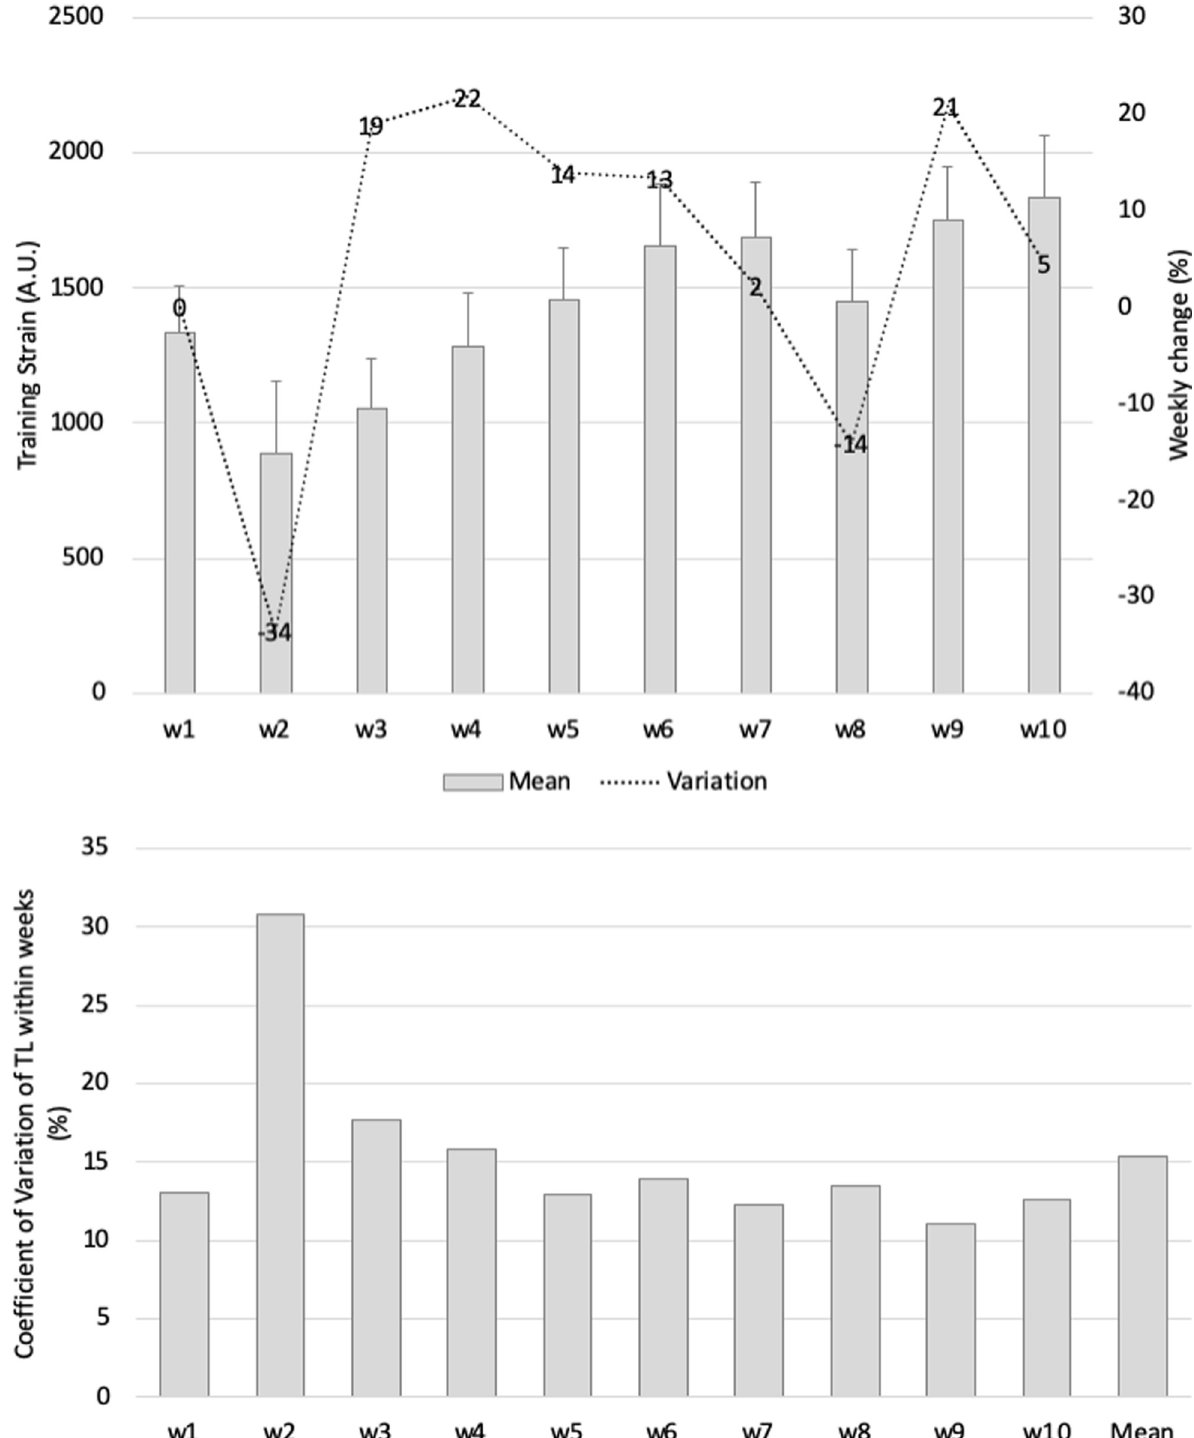
Fig 3. (a) Mean (SD) and weekly changes (%) in weekly training strain during the 10-week study period and (b) within-weekly training strain variations (CV%) and between-weekly training strain variations (CV%).